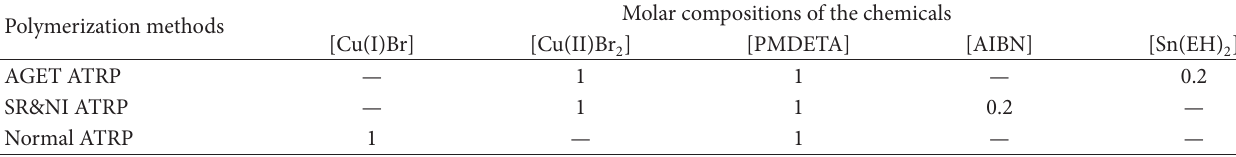
Table 1: Recipes for carrying out ATRP for styrene and chloromethylstyrene with the use of P3HT macroinitiator. Polymerization methods